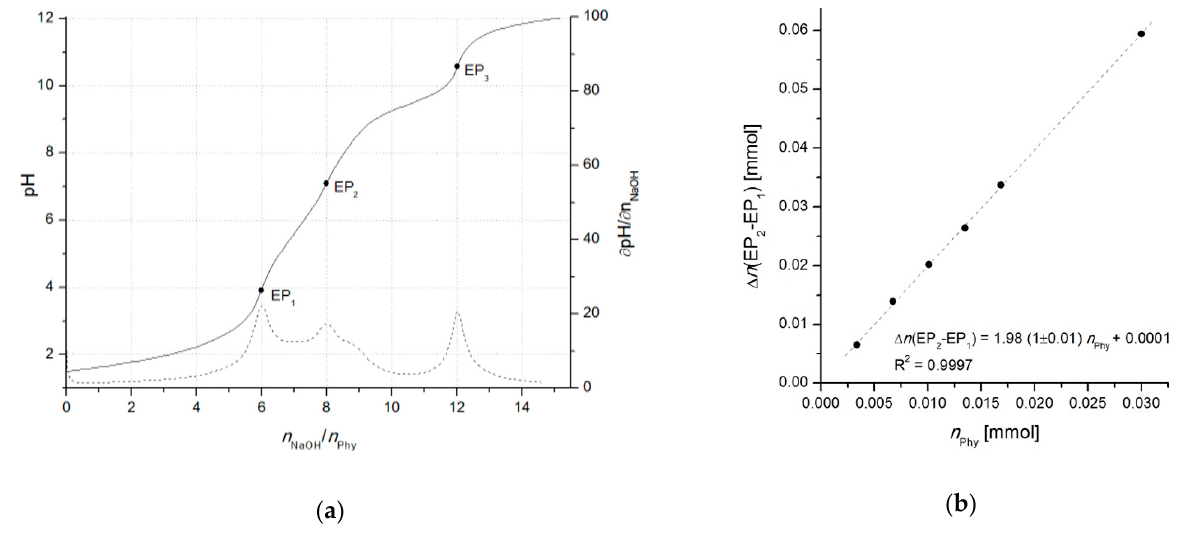
Figure 2. ( a ) Titration curve of 0.3081 mmol of phytic acid in 1.0 M NaCl with 0.0996 M NaOH, accompanied by the corresponding derivative ∂ pH/ ∂ n (NaOH). Equivalent points (three in total) are indicated as EP 1 , EP 2 , and EP 3 , and correspond to the 6th, 8th, and 12th deprotonation step, respectively. ( b ) Calibration curve based on the linear dependance of the difference between the titrant consumption at first (EP 1 ) and second (EP 2 ) equivalent point ( ∆ n(EP 2 –EP 1 )) on the number of moles of titrated phytic acid ( n Phy ). The differential method allows for a reliable standardization of phytic acid regardless on the initial protonation level of phytate. The calculation of phytate amount can be performed also by using other pairs of equivalent points, e.g., EP 1 –EP 3 or EP 2 –EP 3 . Adopted from [50].